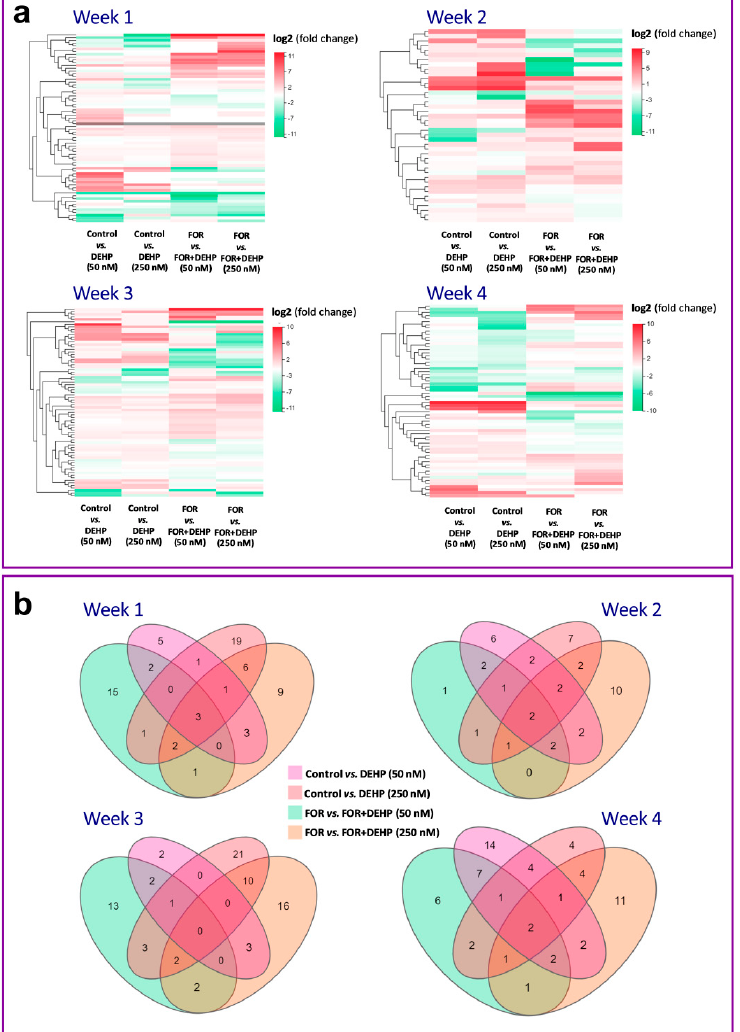
Figure 5. Heatmap and Venn diagrams of deregulated genes in DEHP-exposed HGrC1 cells under the basal and FOR-stimulated conditions. ( a ) Cluster analysis of significantly changed transcripts after 1, 2, 3, and 4 weeks of the repeated DEHP50 and DEHP250 exposure under the basal and FOR-stimulated conditions. Upregulated genes are highlighted in red, and downregulated genes are highlighted in green, whereas those that remained unchanged are in white. ( b ) Venn diagrams show overlapping deregulated genes after 1, 2, 3, and 4 weeks of the repeated DEHP50 and DEHP250 exposures under the basal and FOR-stimulated